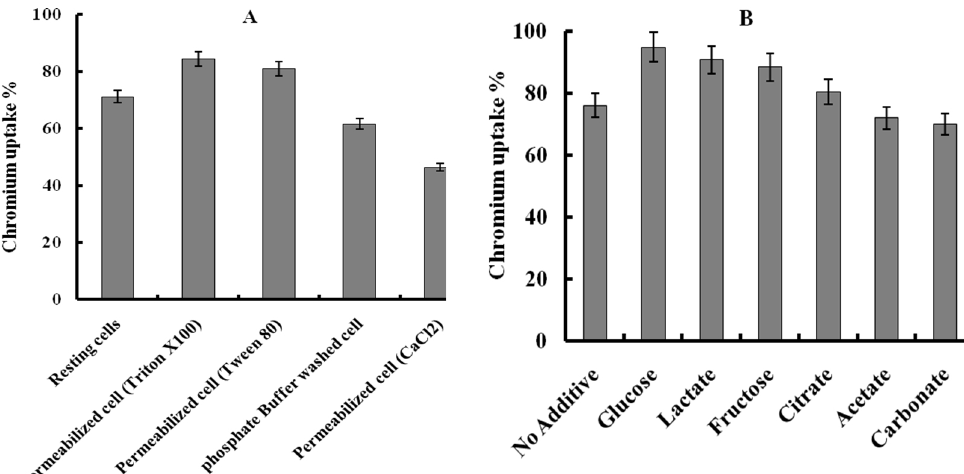
Fig. 4. (A) The influence of permeabilization of whole cell agent on the Cr(VI) reduction. (B) The effect of electron donor on the in vitro chromium